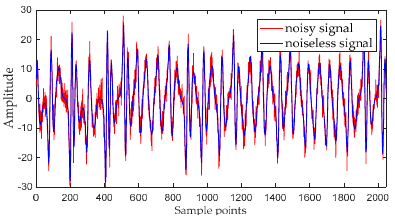
Figure 6. The noisy signal and the noiseless signal.